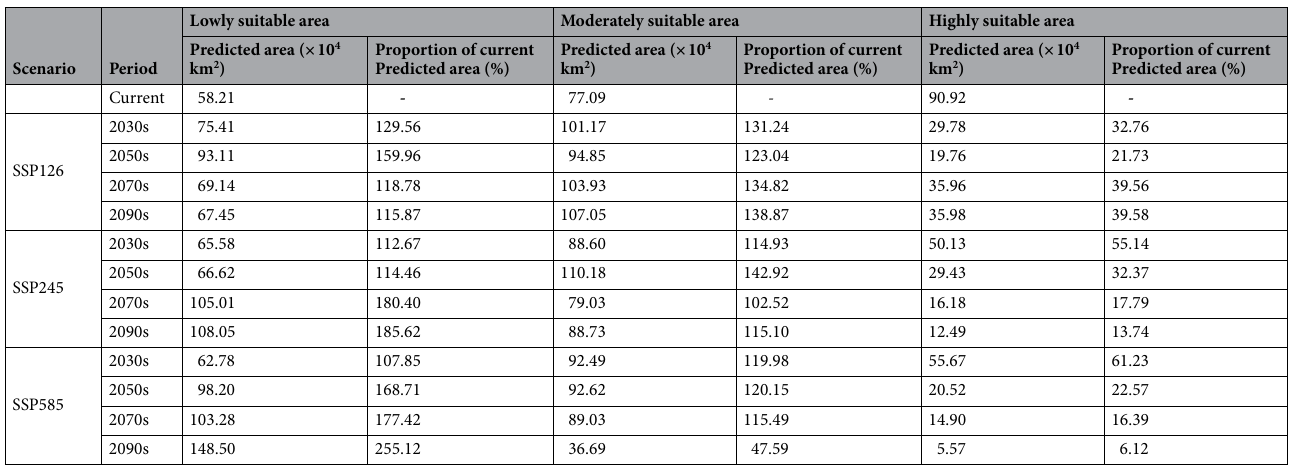
Table 3. Predicted areas of suitable areas for N. californicus under climate changes